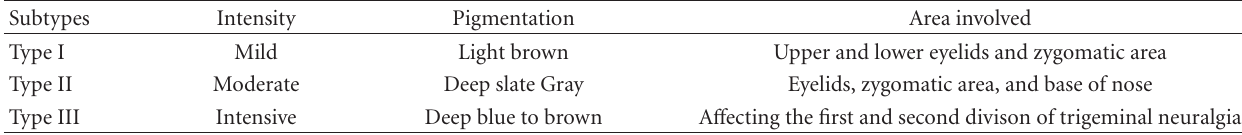
Table 1: Classification of nevus of Ota (Mishima’s classification).